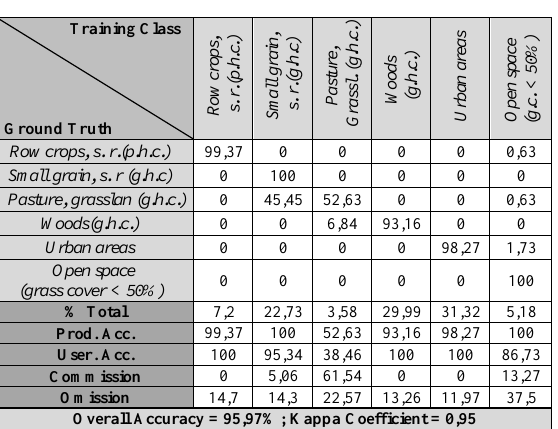
Table 2. Accuracy assessment of the MLP feed-forward NN classification